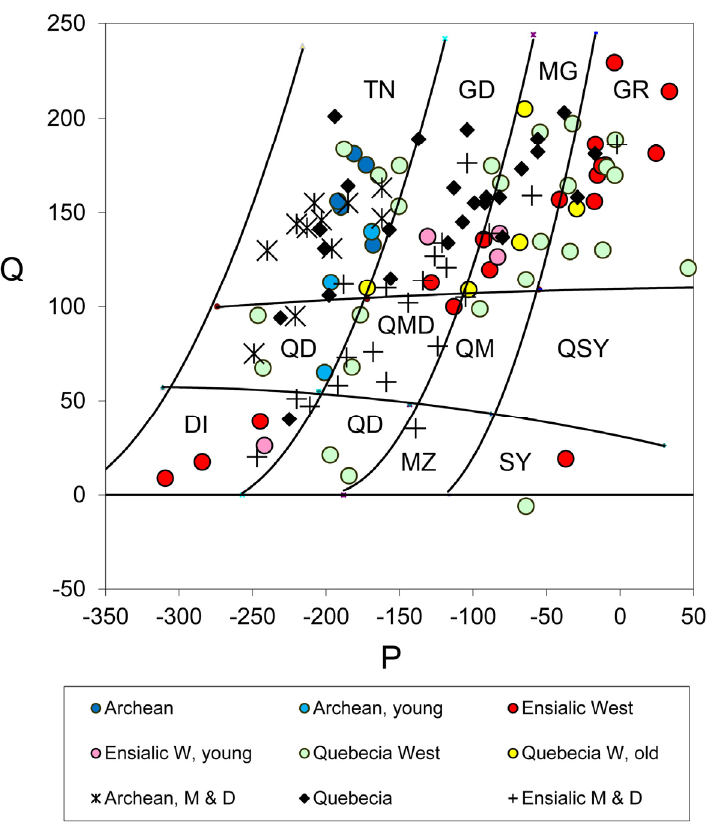
Figure 6. Petrochemical grid after Streckeisen [23] for newly collected samples, compared with the Archean and ensialic arc blocks of Martin and Dickin [4]. TN, tonalite; GD, granodiorite; MG, monzogranite; GR, granite; QD, quartz diorite; QMD, quartz monzodiorite; QM, quartz monzonite; QSY, quartz syenite; DI, diorite; MD, monzodiorite; MZ, monzonite; SY,